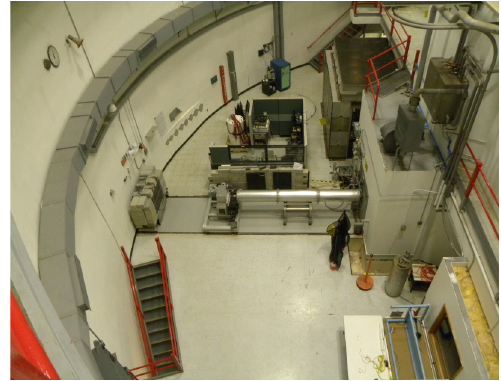
Fig. 1. Thermal column at UML Research Reactor with the removable beam